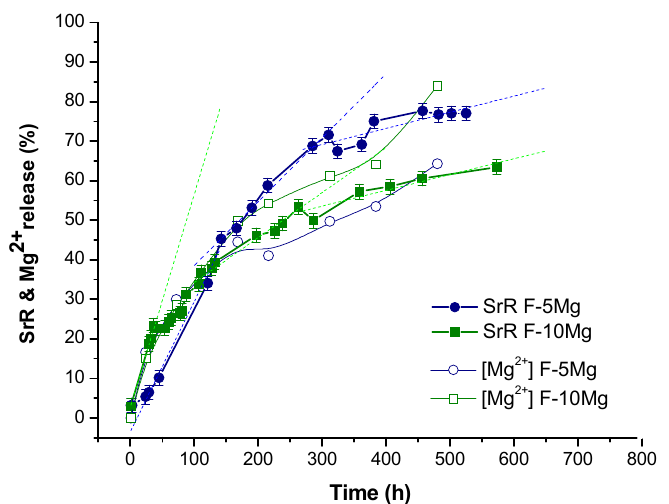
Figure 7. The cumulative release of SrR determined by UV–Vis spectroscopy and the Mg 2+ concen- tration determined by ICP in the immersion medium during the degradation of F-5Mg and F-10Mg films in PBS.